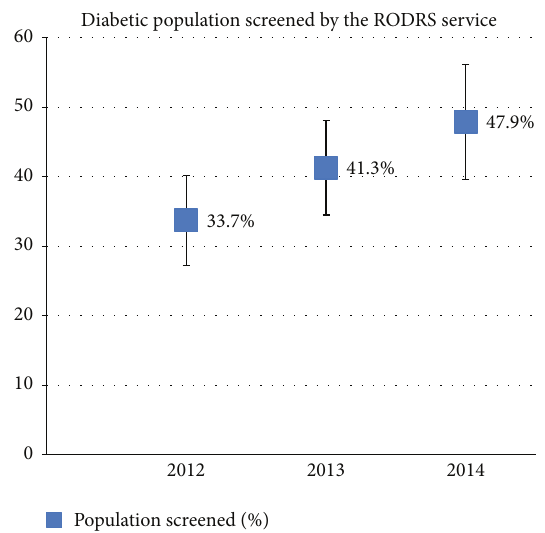
Figure 3: The proportion of the total documented diabetic popu- lation (residing in 11 remote communities) screened each year with 95% confidence intervals shown.